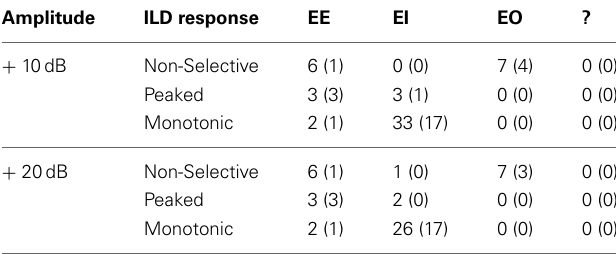
Table 3 | Binaural interactions of IC neurons with different types of ILD response functions.